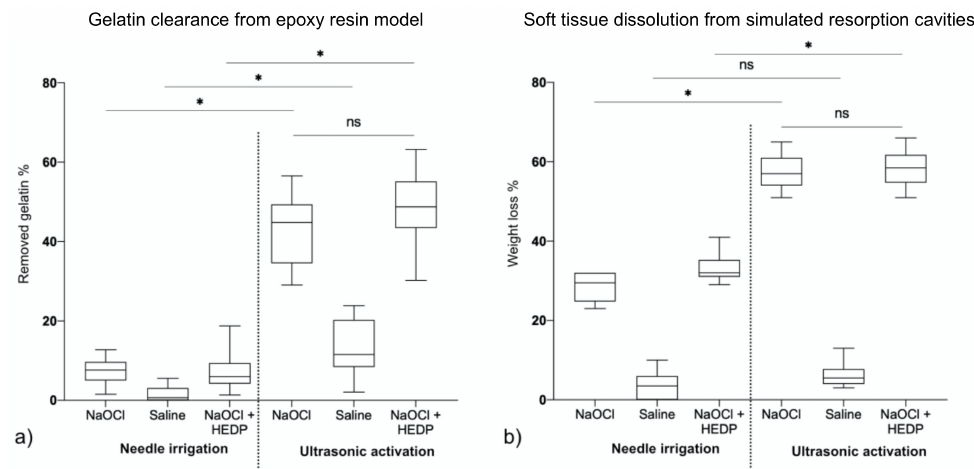
Figure 2. Box plots with error bars indicating maximum and minimum values. ( a ) Experiment 2: Percentage of removed gelatin after different irrigation protocols ( n = 12). Ultrasound activation significantly ( p > 0.001) improved cleaning of the simulated isthmus in the epoxy resin model. Adding HEDP to NaOCl did not change the efficacy of cleaning ( p > 0.05). ( b ) Experiment 3: Similar results were obtained with the soft tissue dissolution from simulated resorption cavities in human root canals, with the only difference that mere irrigation with solutions containing NaOCl did dissolve some tissue. Asterisks denote significant differences between data sets at the 5% level, ns = non-significant, p >